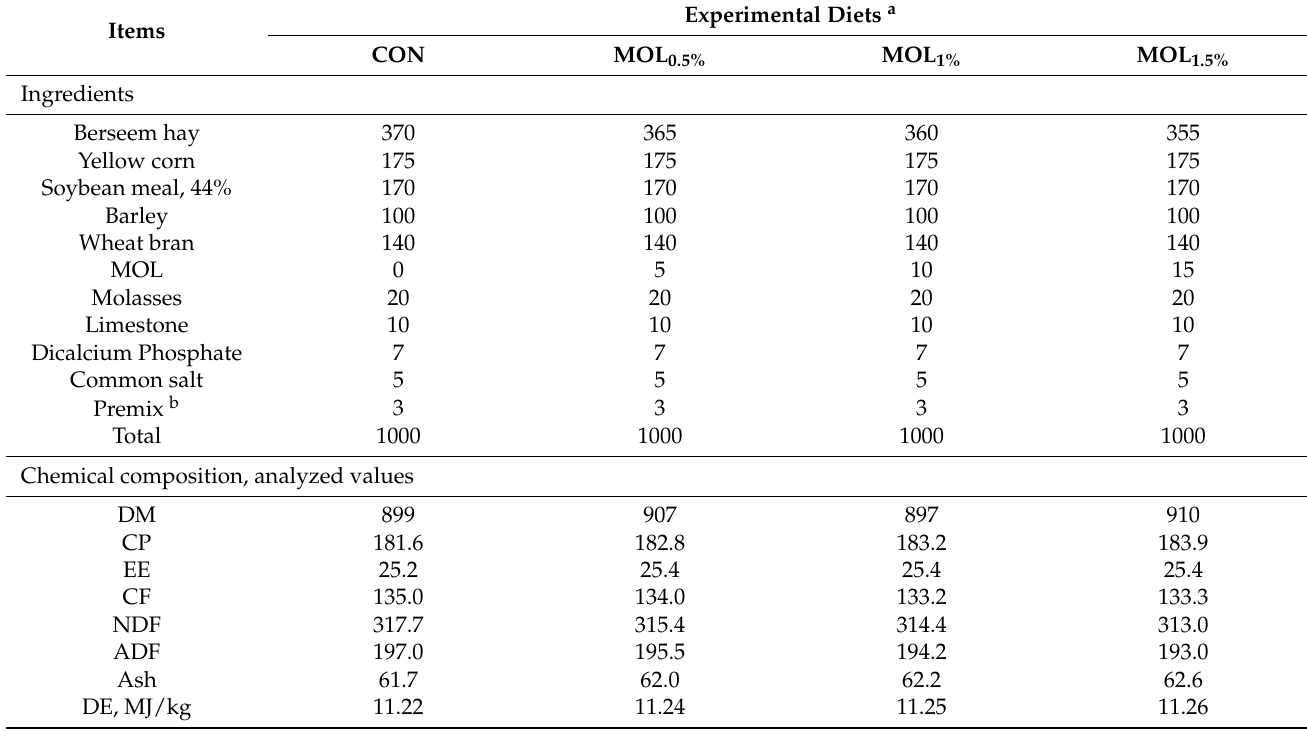
Table 2. Ingredients and chemical composition of the experimental diets (g/kg) as DM